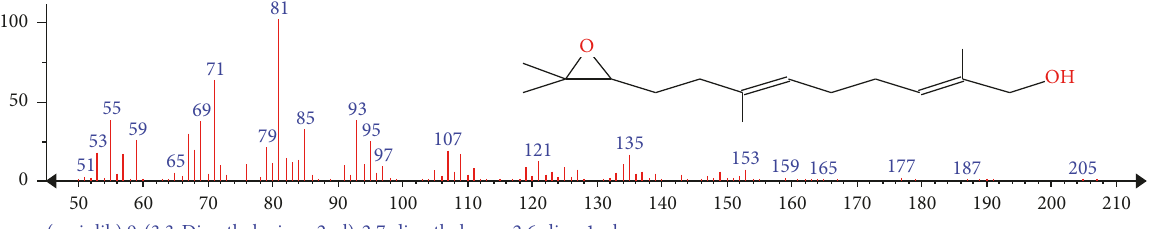
Figure 28: Mass spectrum of compound 9-(3,3-dimethyloxiran-2-yl)-2,7-dimethylnona-2,6-dien-1-ol of whole plant hexane fraction of Achillea wilhelmsii (WHFAW).